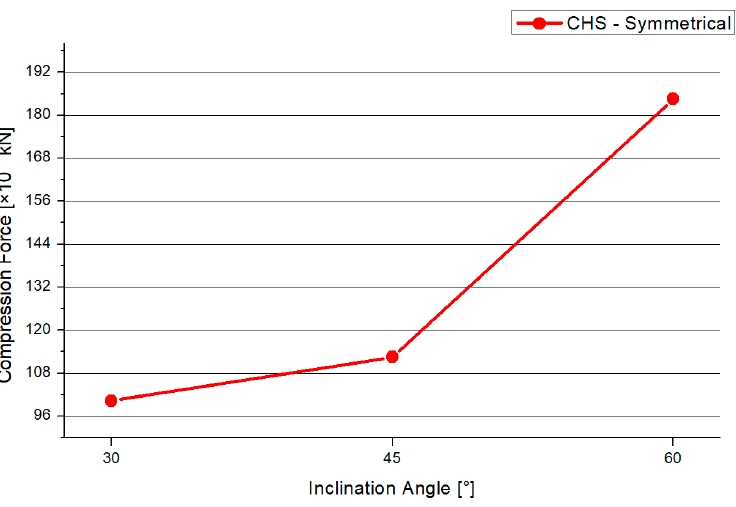
Figure 5. Maximum Compression Force CHS Symmetrical.